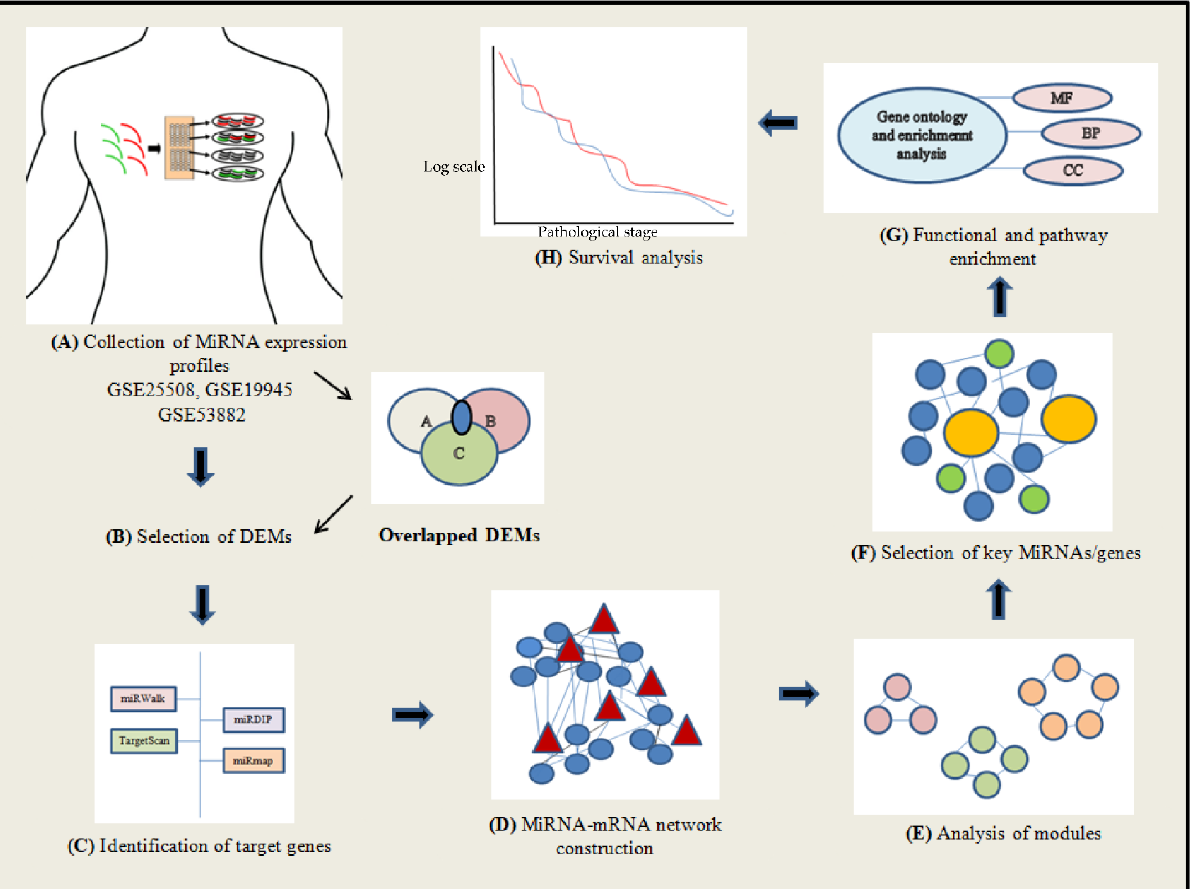
Figure 1. Illustration of the network-based integrative method used in the study. ( A ) Three NSCLC series (GSE25508, GSE19945, and GSE53882) were used for the present analysis. ( B ) The DEMs were identified using comparative approach. ( C ) The target genes associated with DEMs were identified. ( D ) The mRNA–miRNA network was constructed. ( E ) The significant modules based on centrality methods were detected. ( F ) The key miRNAs and their associated genes were obtained. ( G ) Enrichment of function and pathway analysis was performed for the identified key elements (key miRNAs and key genes). ( H ) Survival analysis for the obtained key genes was conducted through survival plots.